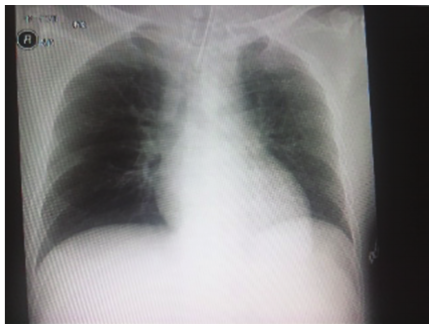
Figure2:Chestroentgenogramafterreintubationisshown.Marked shadow of the butterfly is